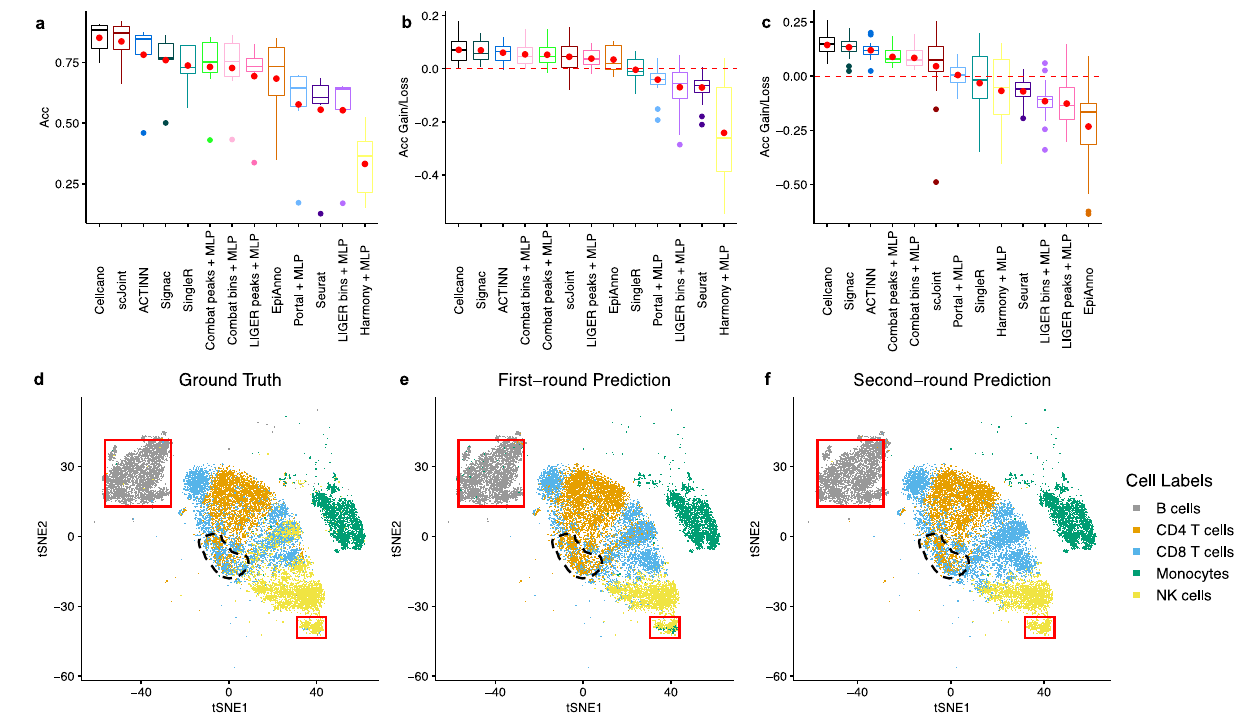
Fig. 3 | Performance comparisons between Cellcano and other competing methods along with illustrations on how Cellcano outperforms. a – c Accuracy comparisons between Cellcano, Seurat, scJoint, Signac, SingleR, ACTINN, and EpiAnno along with other integration with label transfer methods on ( a ) n =7 celltyping tasks using one human PBMCs FACS-sorted dataset as target, ( b ) n =22 more human PBMCs celltyping tasks and ( c ) n =21 mouse brain celltyping tasks.